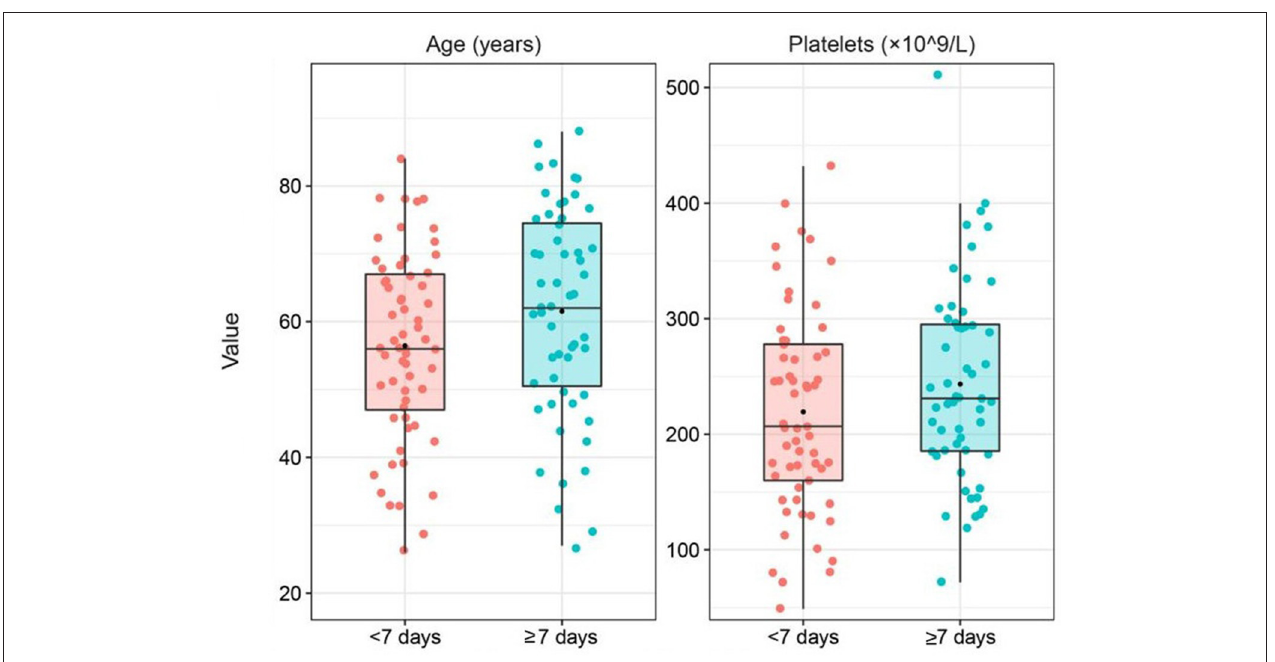
FIGURE 1 | Box plot of variables grouped by the time from symptom onset to positive nucleic acid test was combined with the results of the univariate cox regression analysis and expertise.